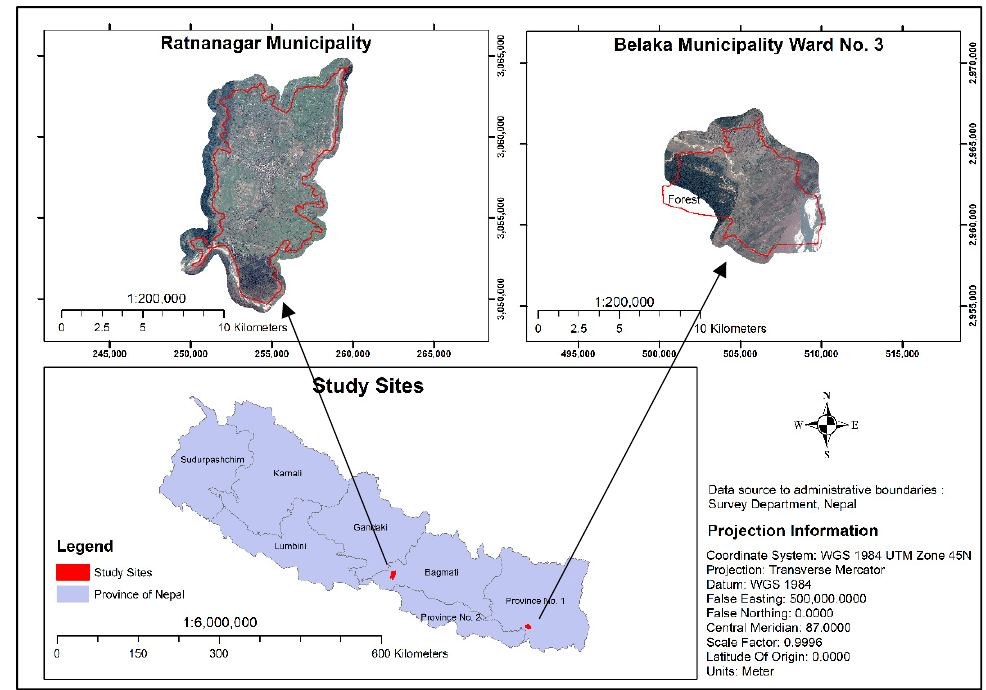
Figure 1. Study sites.